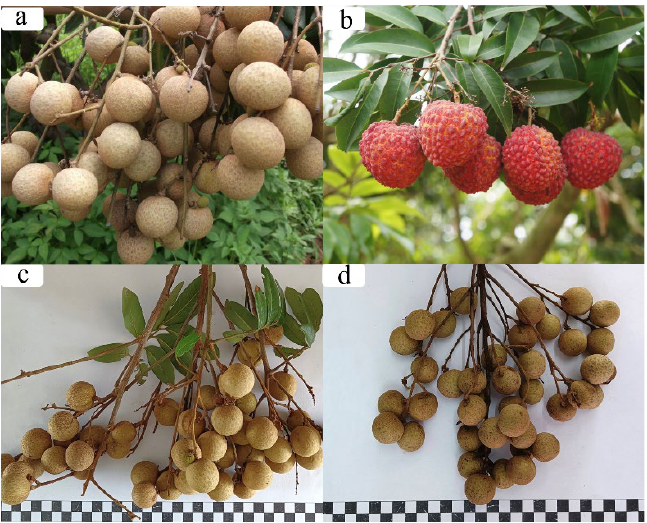
Figure 1. The mature fruit of ‘Huanongzao’, ‘Ziniangxi’ and two F 1 hybrids. Note: ( a ):